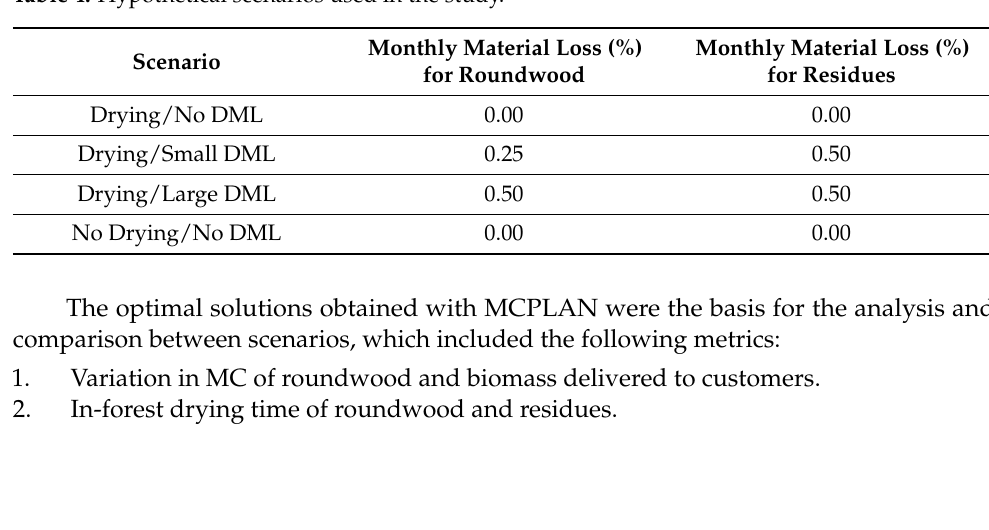
Table 4. Hypothetical scenarios used in the